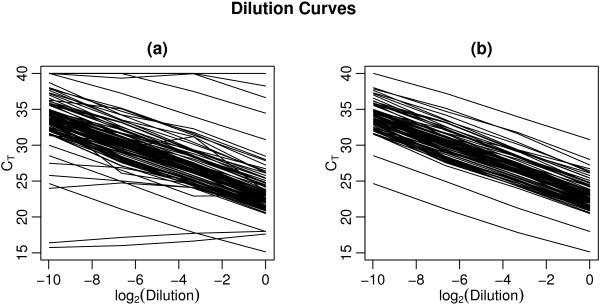
Relationship between CT and log2(dilution) for all 96 primers before (a) and after (b) removing relatively unreliable primers. CT values are shown on the vertical and log2 dilution of input target on the horizontal axis. Note the purged data is much "cleaner", with non-linear and sporadic relationships removed.